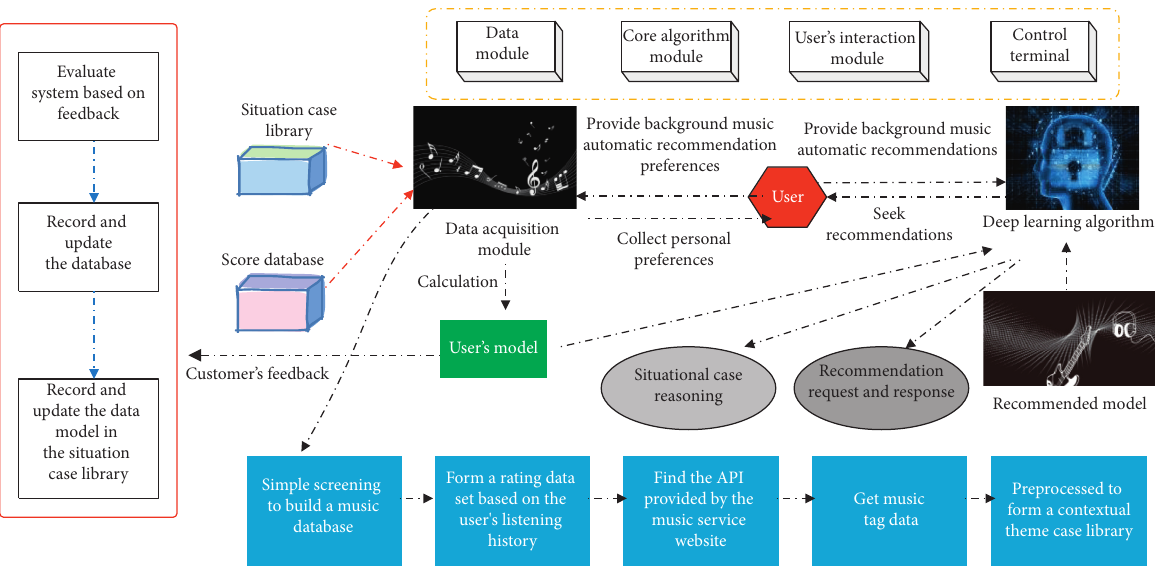
Figure 1: Overall architecture of the video background music recommendation